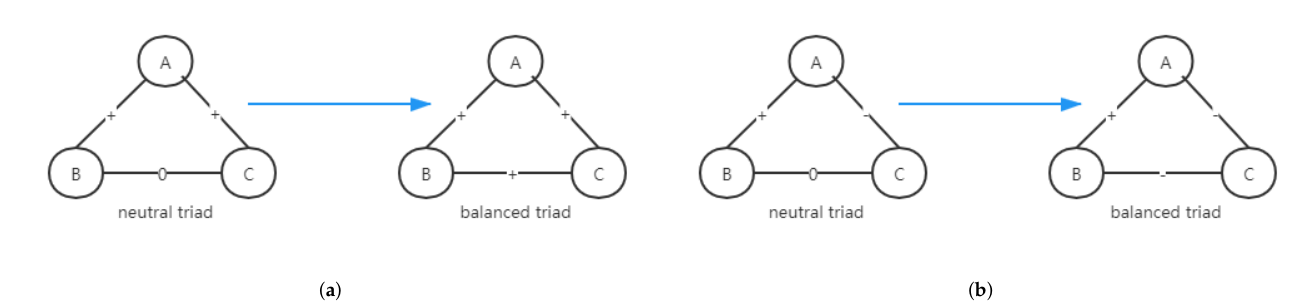
Figure 21. Changes of neutral edge: ( a ) the edge between nodes B and C evolves from 0 to + 1; ( b ) the edge between nodes B and C evolves from 0 to −